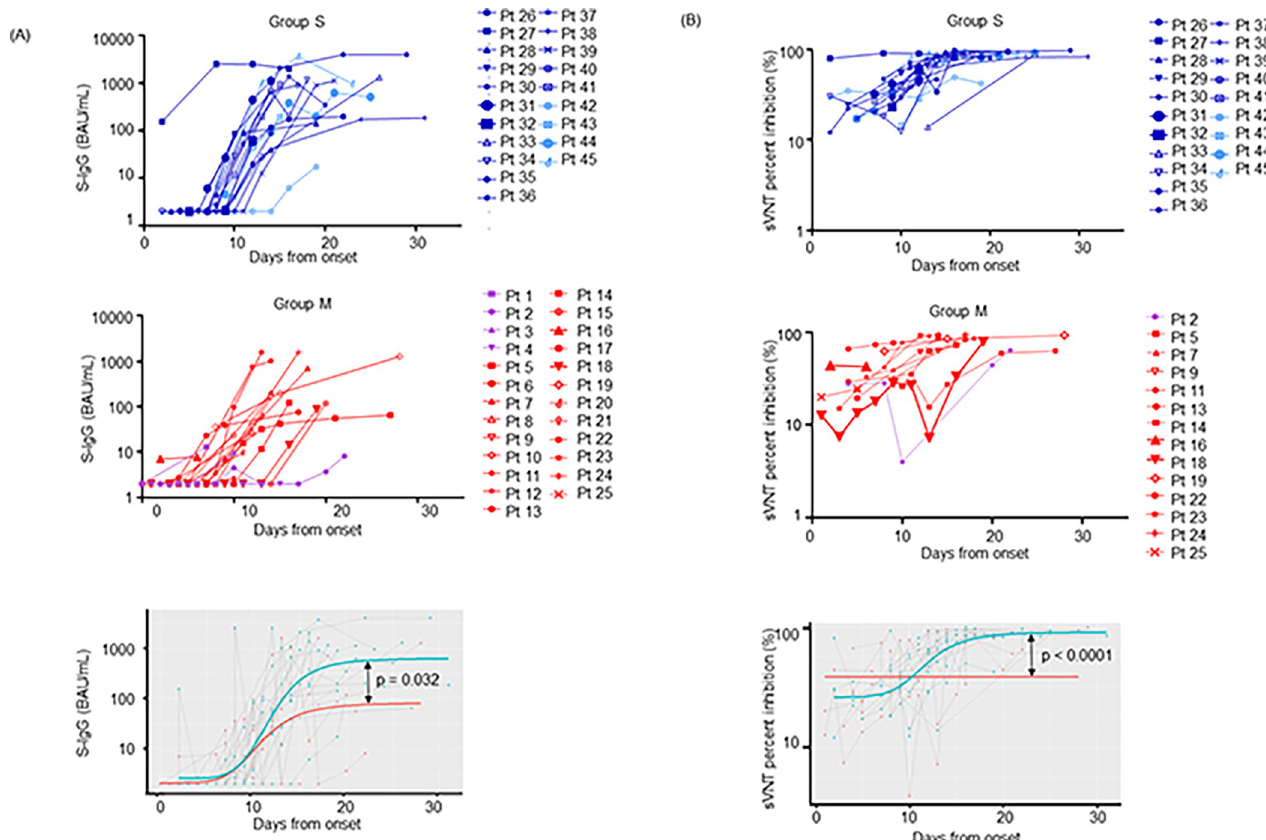
Fig 4. Longitudinal change of S-IgG and sVNT values.